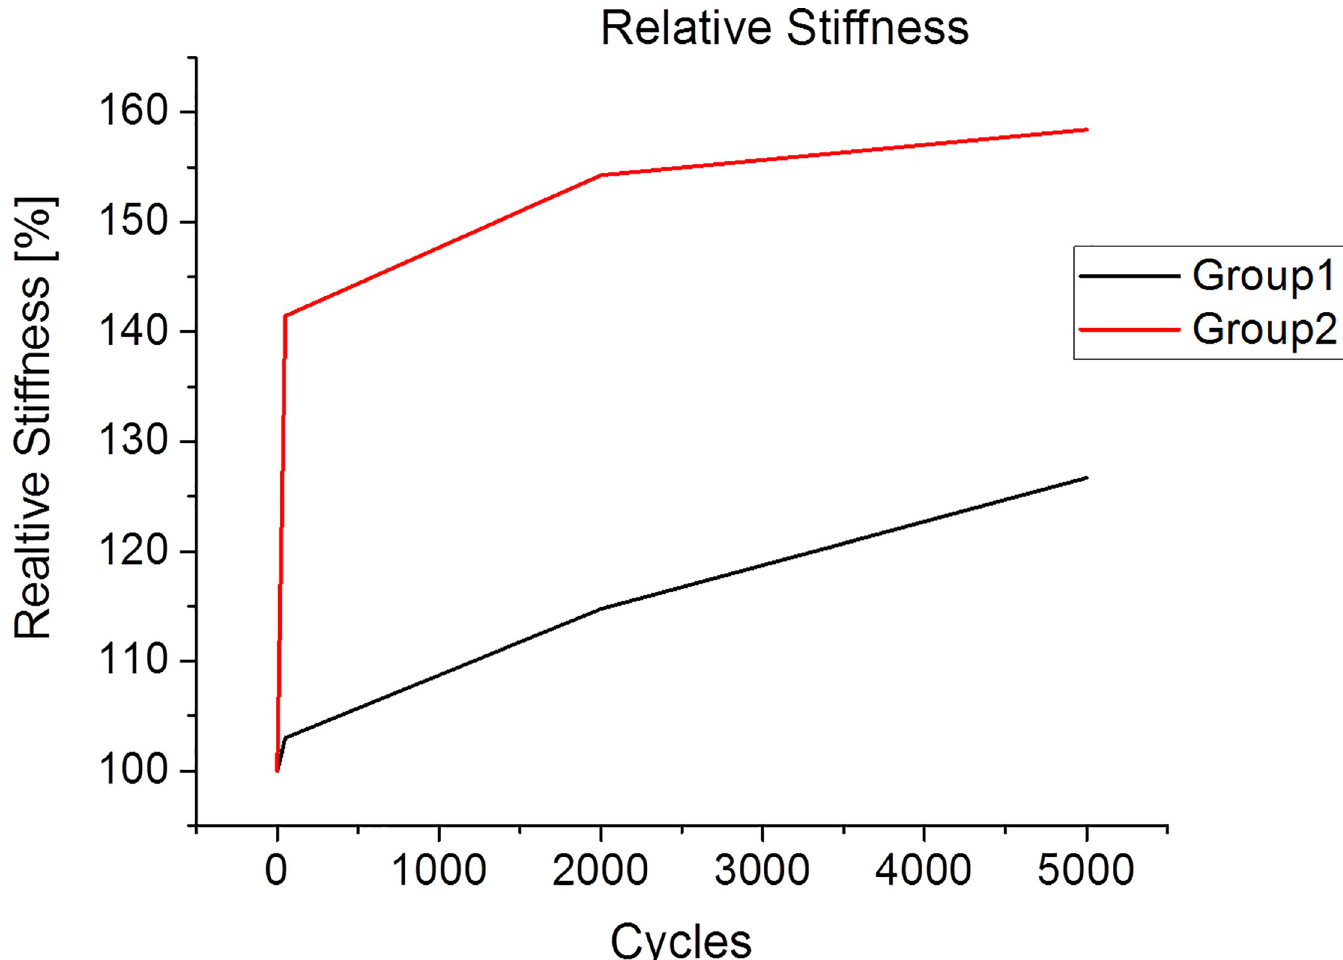
Fig 5. The curve of the average relative stiffness of the cyclic test for each group and the first cycle set to 100%.